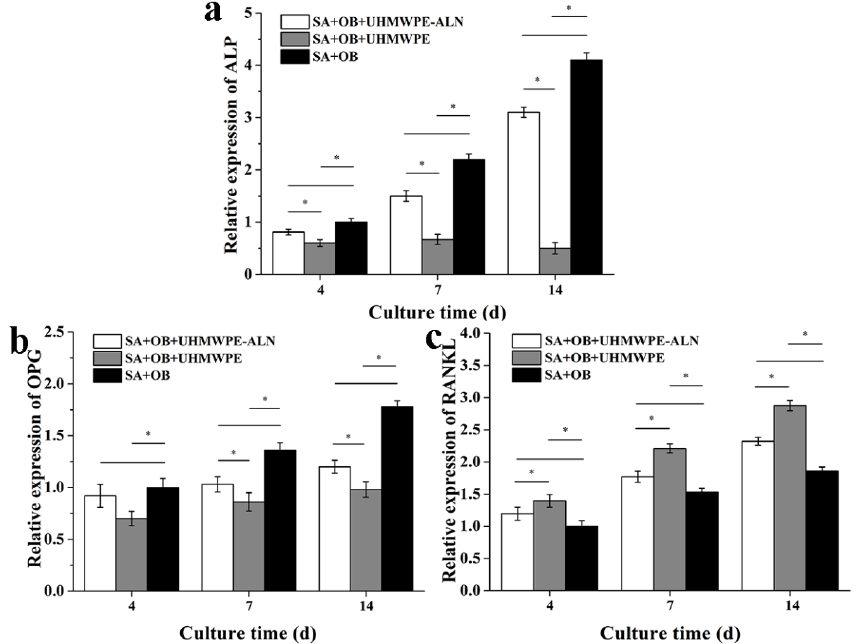
Figure 7. Relative gene expressions of ALP ( a ), RANKL ( b ), and OPG ( c ) in osteoblasts after being co-cultured with critical-sized UHMWPE-ALN wear particles for 4, 7, and 14 d by RT-PCR analysis ( n = 3, * p < 0.05).